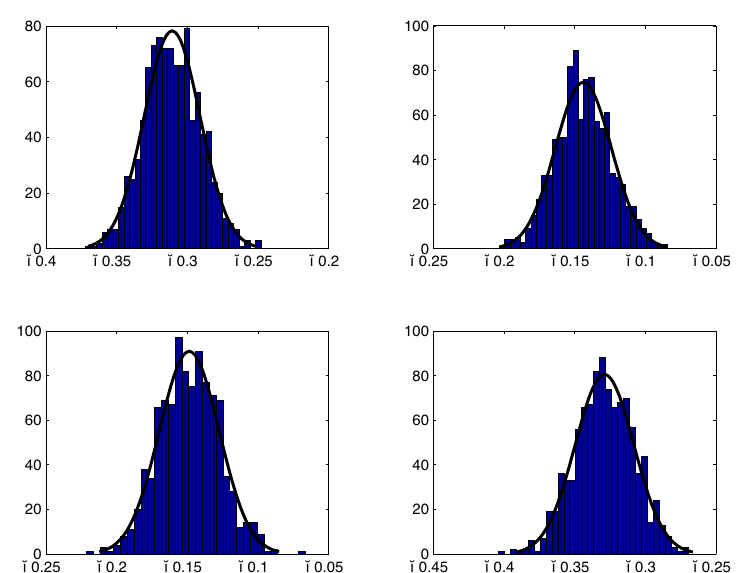
Figure 1: Bootstrap distributions of the component sample means. IC-1, top-left; IC-2 top-right; IC-3 bottom-left; IC-4